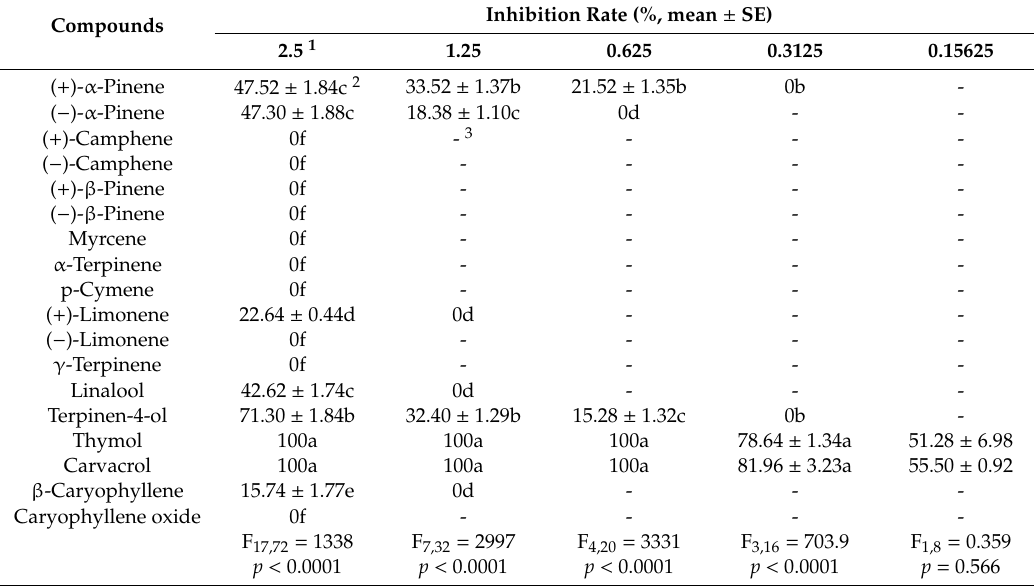
Table 6. Fumigant antifungal activities of constituents from summer savory and thyme white essential oils against R. solani